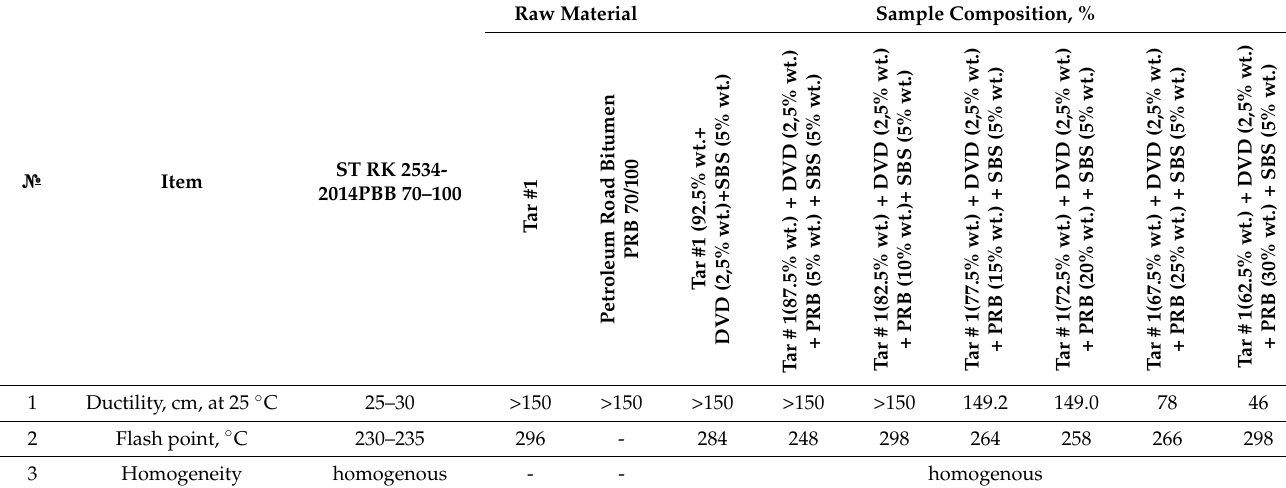
Figure 4. Dependence of brittleness temperature on Fraass on petroleum road bitumen concentration. Table 5. The test results of the modified bitumen at different concentrations of the petroleum road